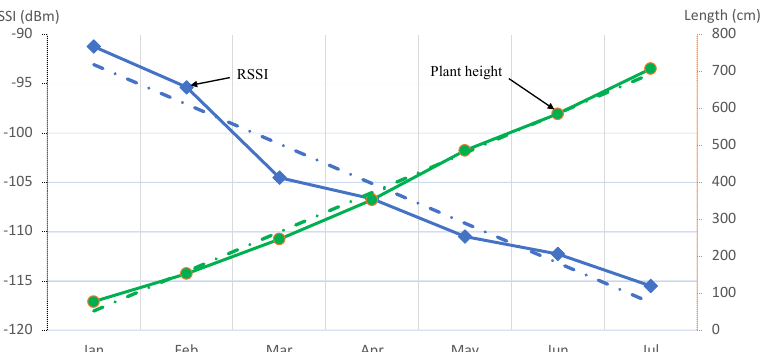
Figure 6. Relation of RSSI and plant growth over the period of 7 months from January to July for tomato crop.